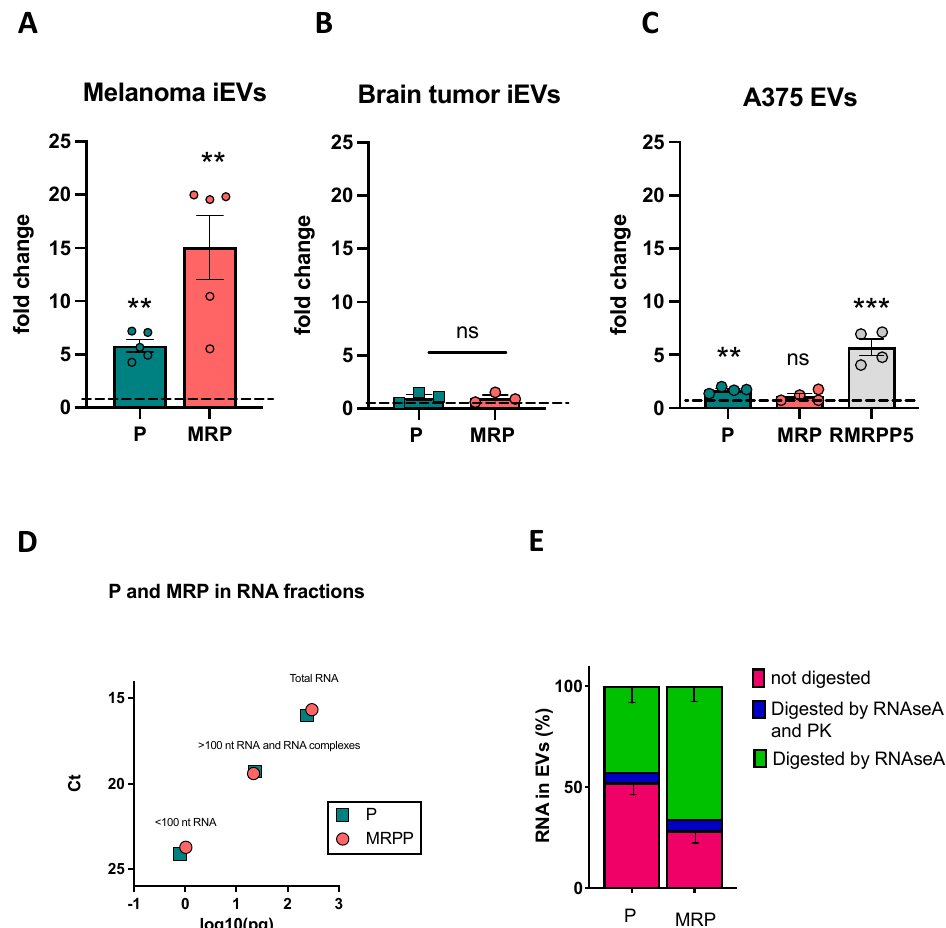
Figure 4. QPCR validation of P and MRP RNAs enrichment in iEVs. ( A – C ) Expression of P and MRP (and RMRPP5 in human cells/EVs) RNA in melanoma iEVs compared to the expression in melanoma ( A ), in brain tumour iEVs compared to the expression in tumour cells ( B ), and in A375 EVs versus A375 cells ( C ). In all graphs, expression in the cells of origin of the iEVs/EVs is set at 1, and data are normalized to the levels of rnu6.1/RNU6. n > 3 as represented; ** p < 0.01; *** p < 0.001. ( D ) Graphic representation of the amount of P and MRP found in the lower fraction (fragmented RNA), higher fraction (RNA and RNA–protein complexes), and total RNA of A375 EVs, following UV crosslinking. Values are expressed in pg and are calculated from the number of ct of a reference scale obtained with serial dilutions of P and MRP cDNA templates (see Section 4.16). ( E ) Percentages of P and MRP RNA lost in RNAseA digested and RNAseA + proteinase K digested in A375 EVs, as indicated. Data are from 3 biological replicates +/ − SD. ns: not signi fi cant.